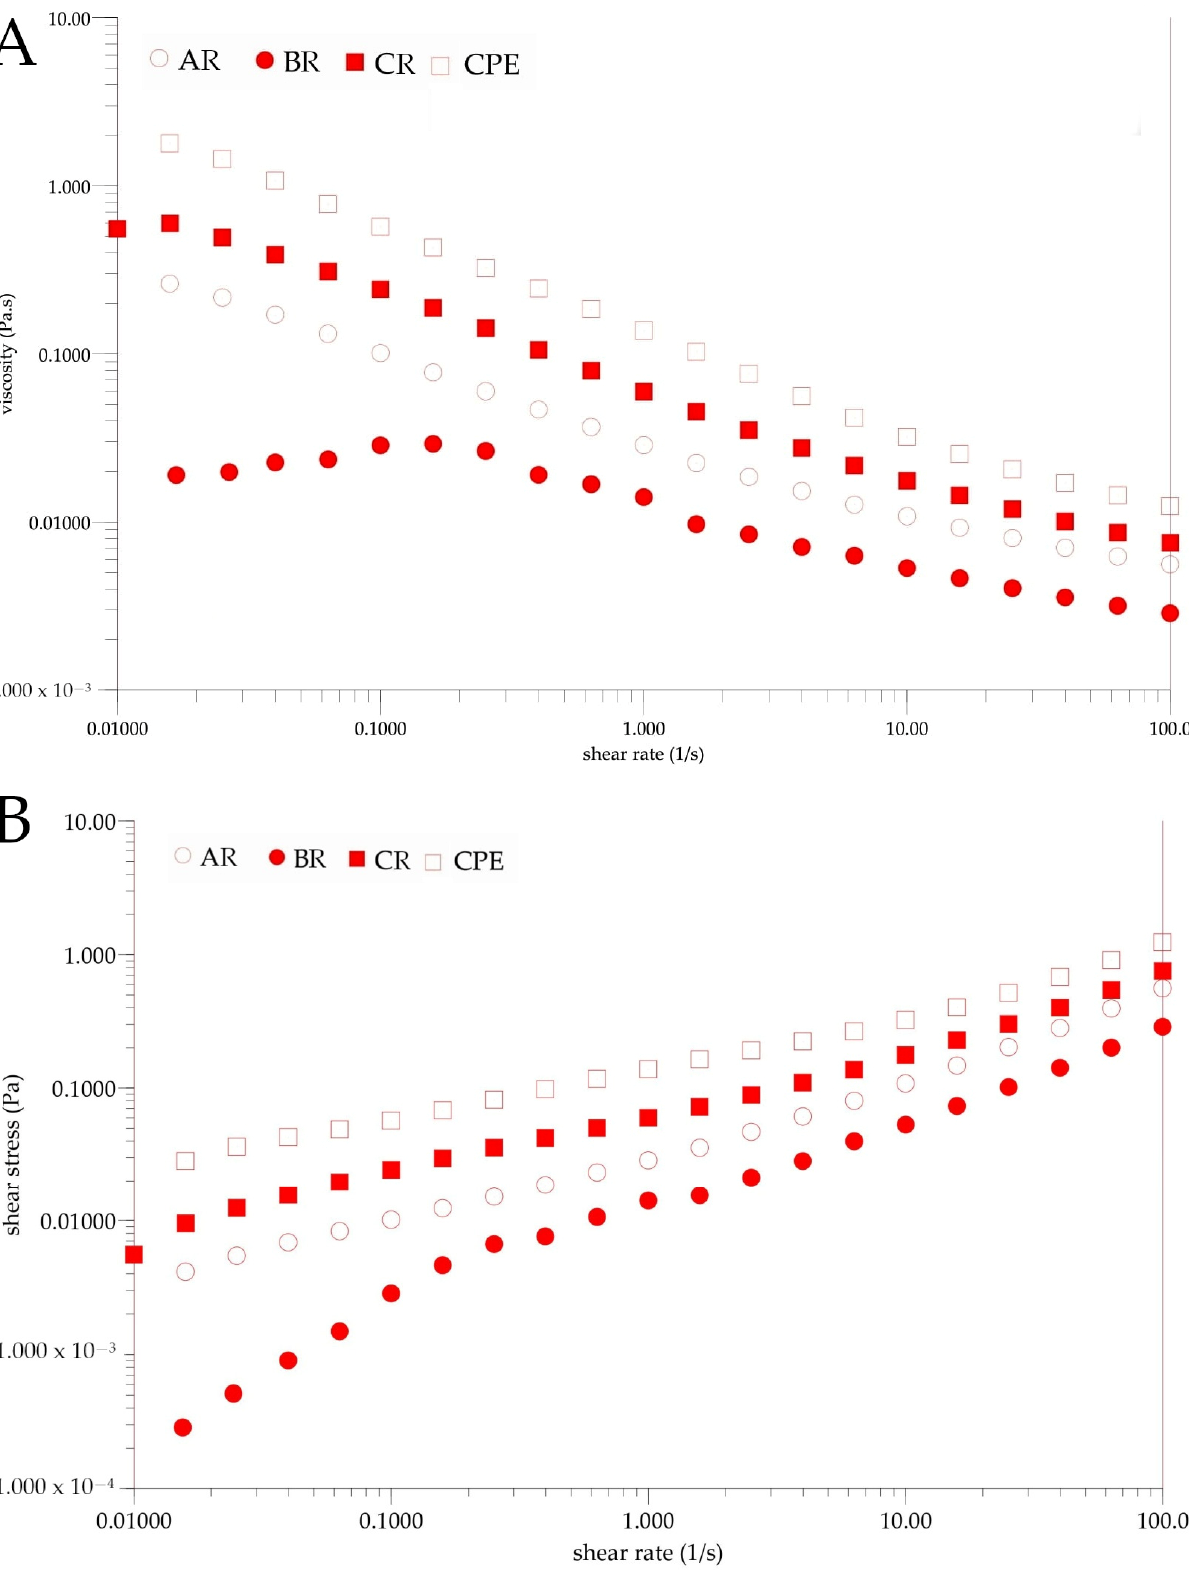
Figure 5. Rheograms of CPE and reconstituted samples. ( A )—Changes of viscosity. ( B )—Changes of shear stress. CPE: Camelina Press Cake Extract; AR: reconstituted sample spray-dried at 140 ◦ C; BR: reconstituted sample spray-dried at 160 ◦ C; CR: reconstituted sample spray-dried at 180 ◦